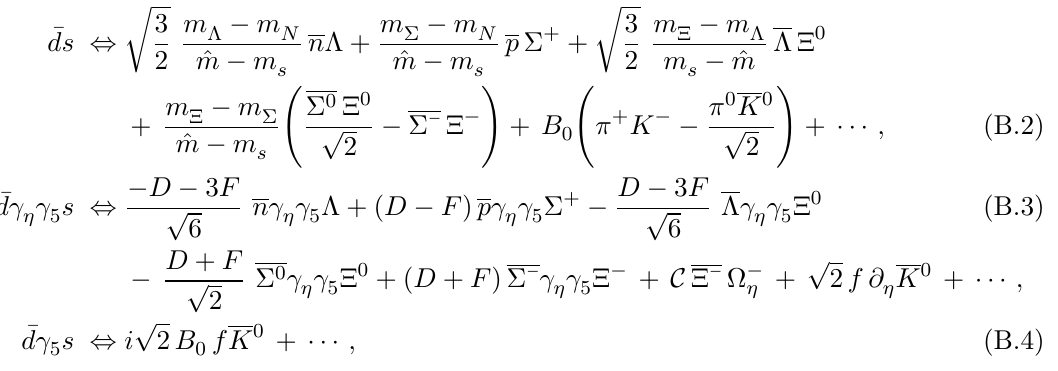
corresponds U i D j